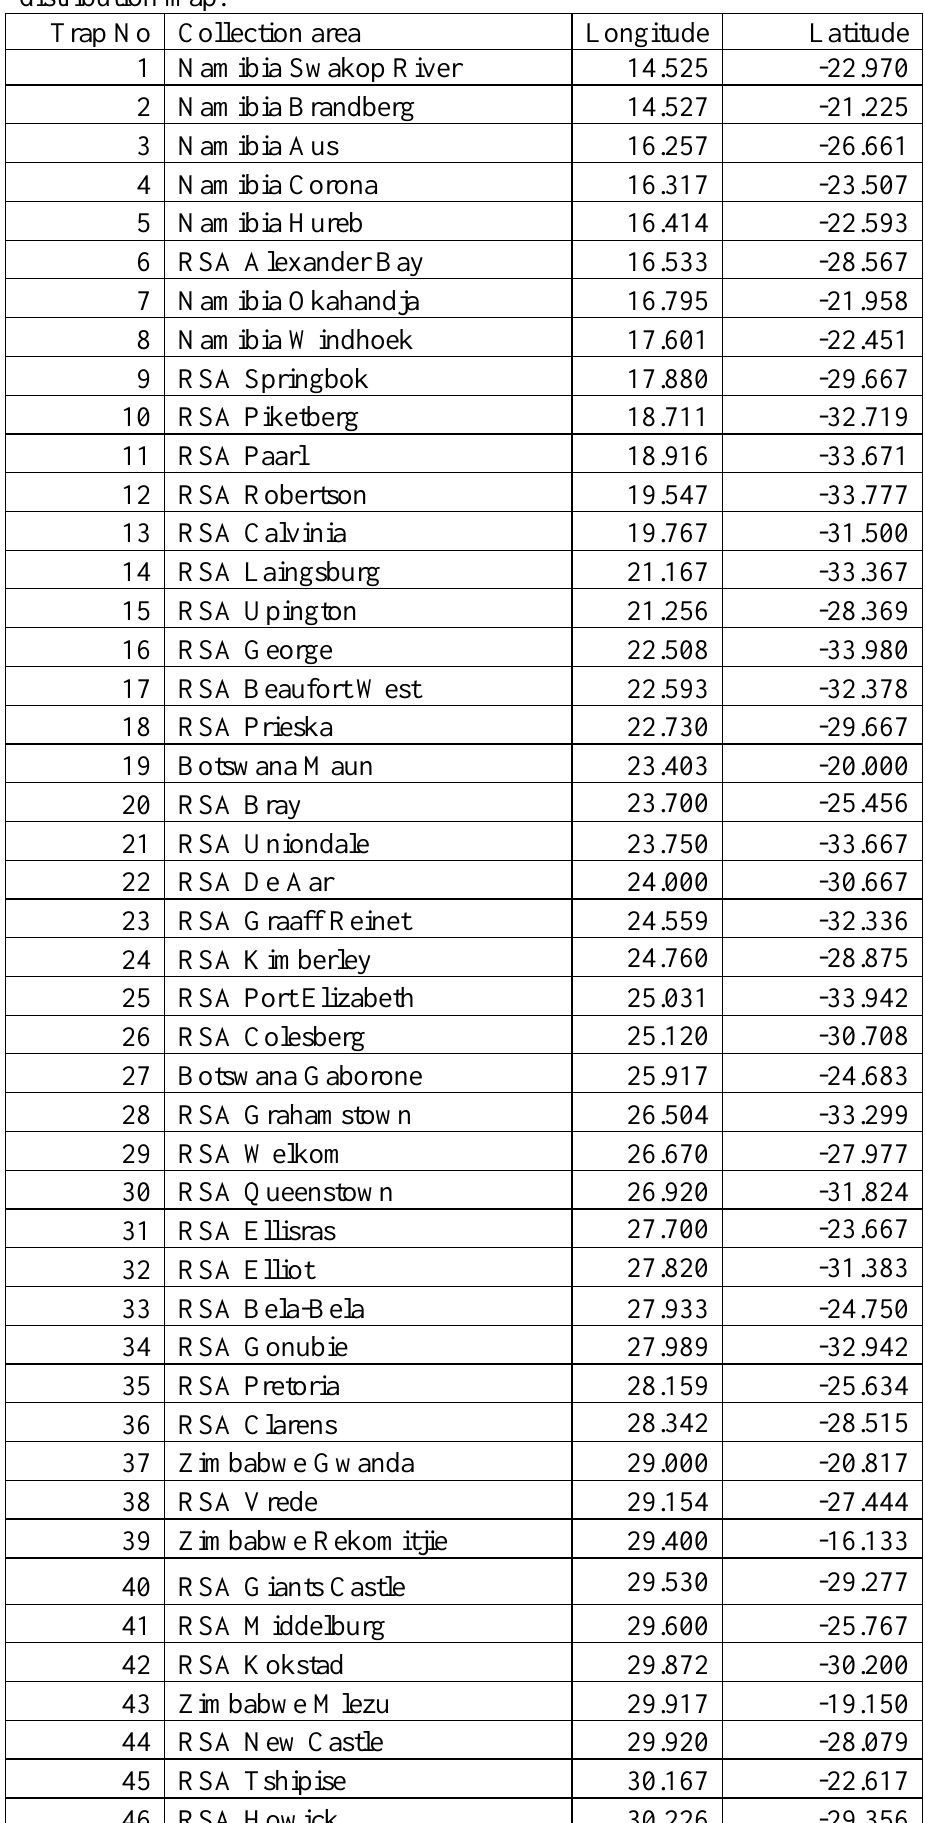
TABLE 2-A1 . Collections sites with longitude and latitude co-ordinates used in the generation of the distribution